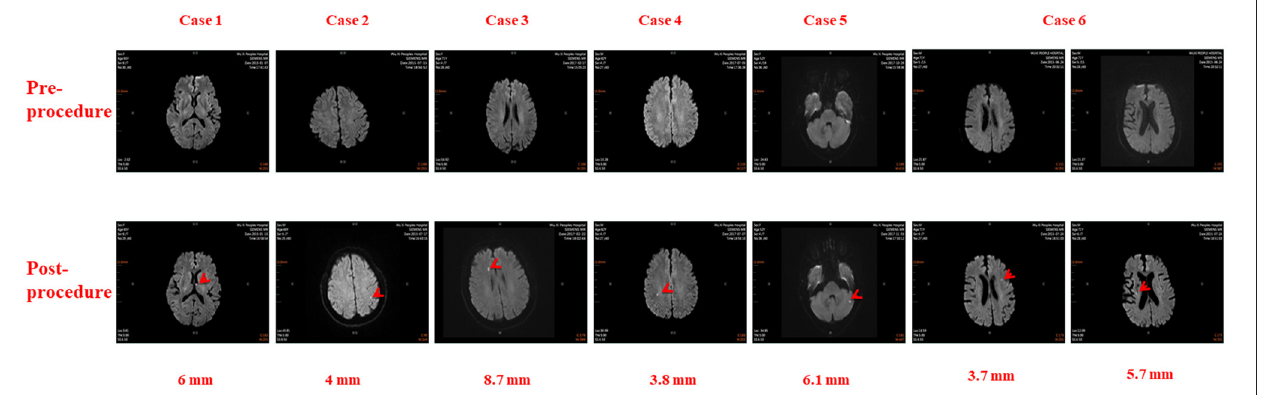
FIGURE 1 | Cerebral Magnetic Resonance Images in six patients before and after Atrial Fibrillation Ablation using Magnetic Navigation System: Case 1: Left thalamus (6mm), Case 2: Left parietal lobe (4mm), Case 3: Right frontal lobe (8.7mm), Case 4: Right parietal lobe (3.8mm), Case 5: Left cerebellum (6.1mm), Case 6: Left frontal lobe (3.7mm) and Right corona radiata